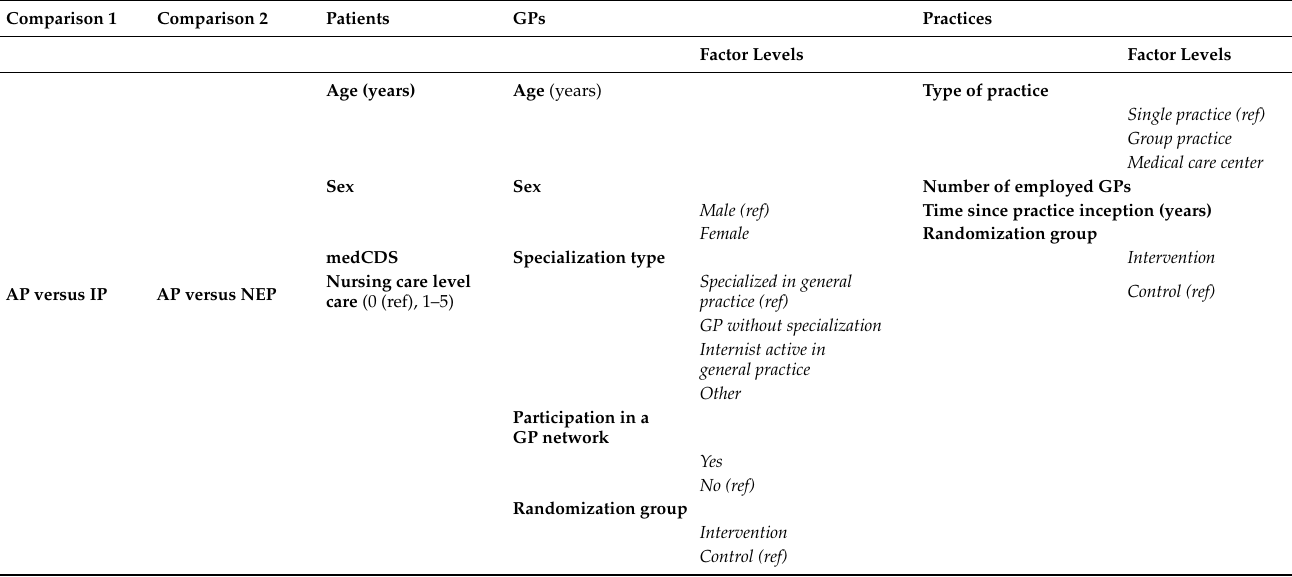
Table A1. Variables for the Reach dimension (ref = reference category in logistic